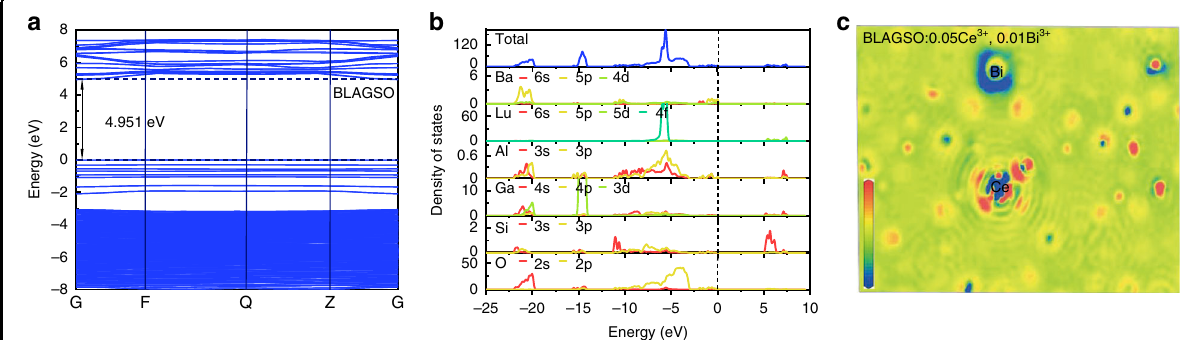
Fig. 2 Electronic structure. a Band structure of BLAGSO. b DOS of BLAGSO. c Charge density difference of Ce and Bi in BLAGSO:0.05Ce 3 + , 0.01Bi 3